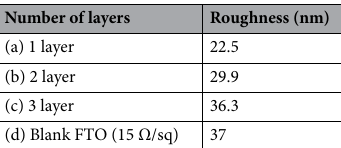
Table 1. Relationship between layers and